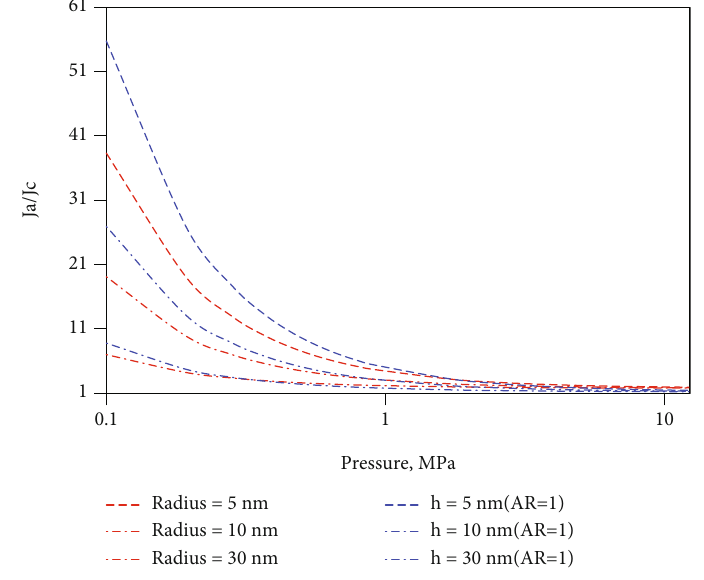
Figure 6: E ff ect of pore size on gas transport